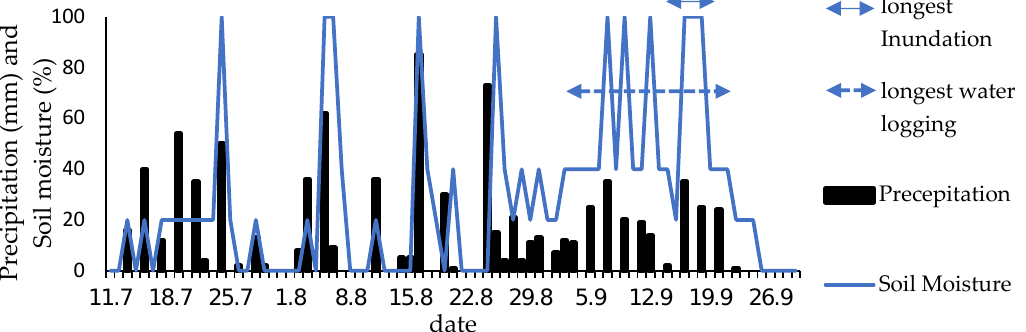
Figure 3. Inundation, waterlogging, and precipitation on experimental plots. Bright blue = Precipitation in mm day −1 . Visual Soil moisture assessment is presented in %(volumetric): 20% = moist topsoil, 40% = saturated topsoil with water in plow lines, 100% = inundation. Cultivar effects were insignificant.